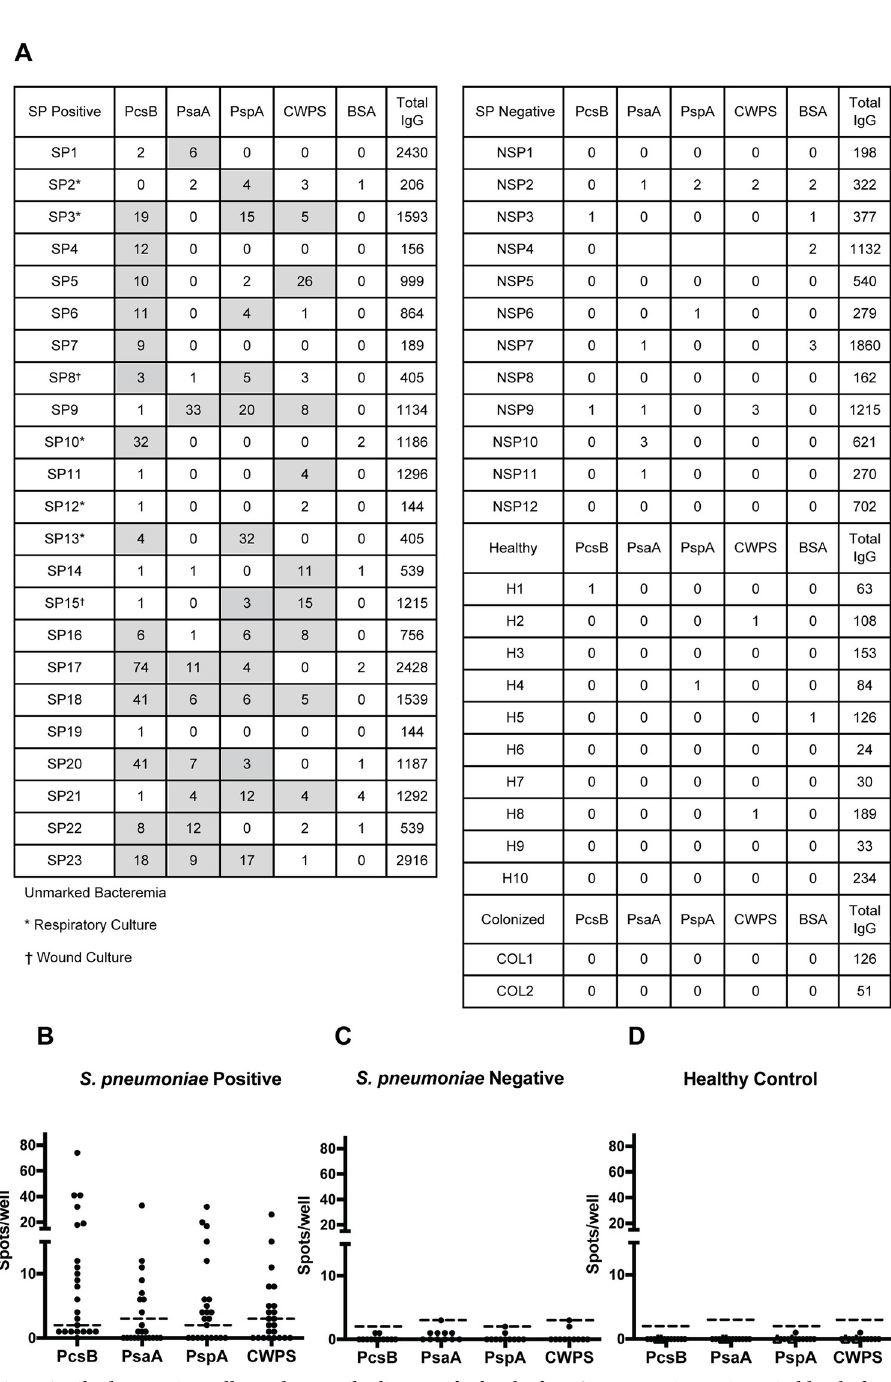
PLOS ONE | https://doi.org/10.1371/journal.pone.0259644 November12, 2021 8 /